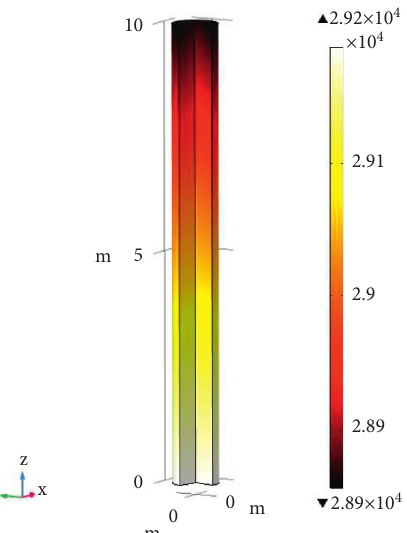
Figure 3: Heat of the